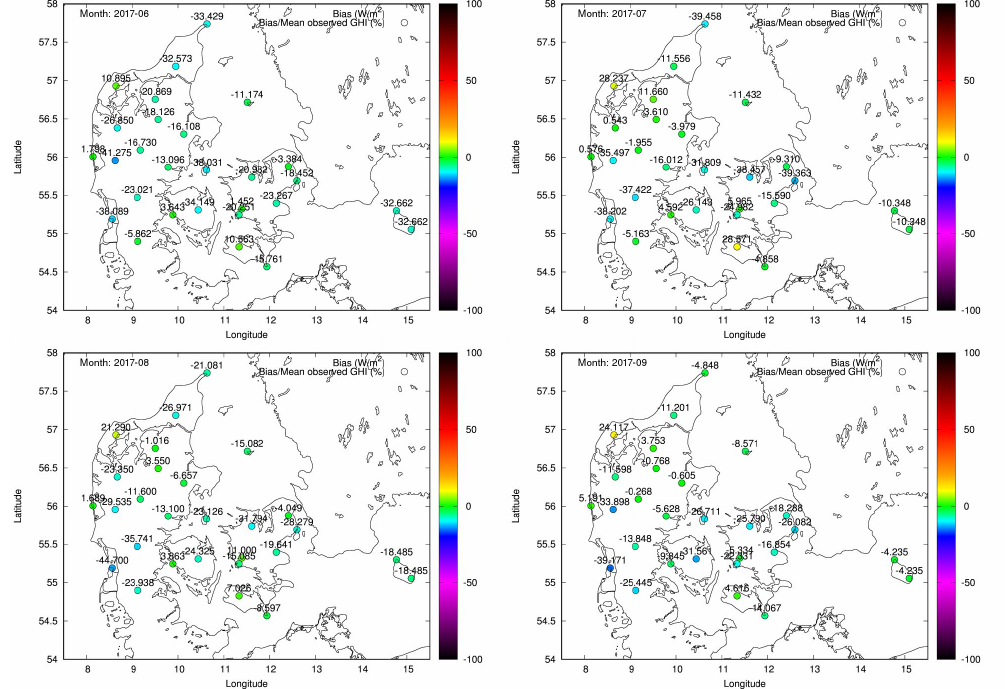
Figure 7. Monthly mean biases in GHI per station in Denmark for the months of June, July, August and September in 2017. The colour shows the relative GHI bias with respect to the measured